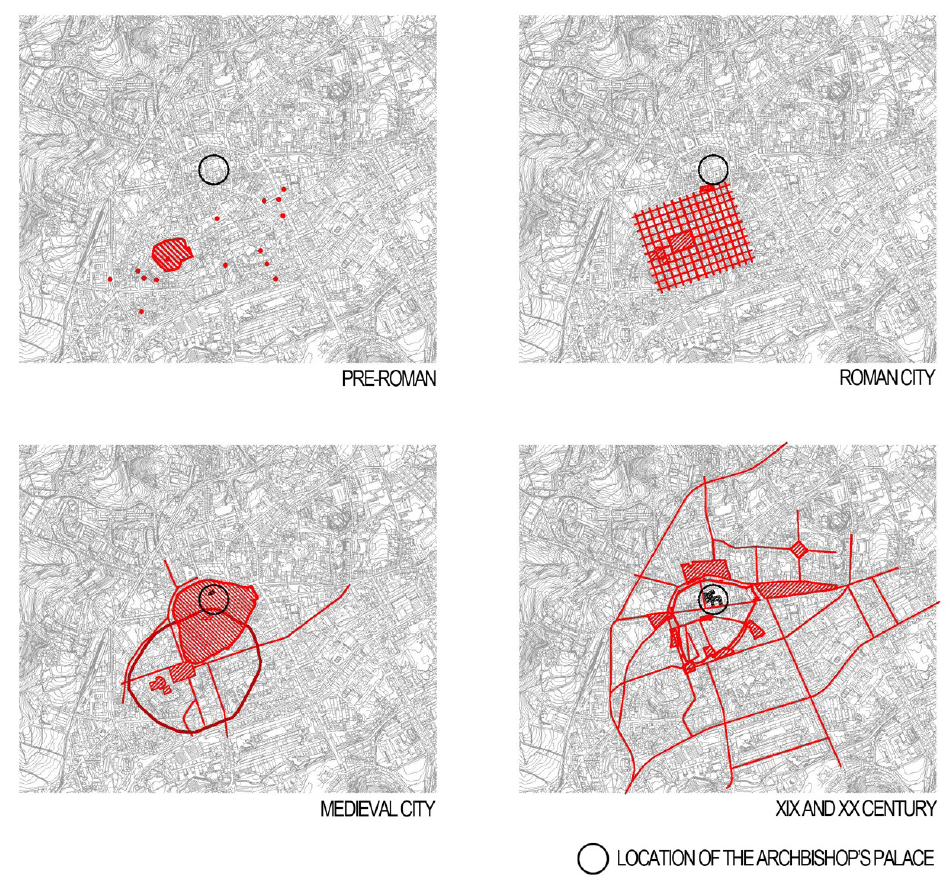
Figure 1. Evolution of